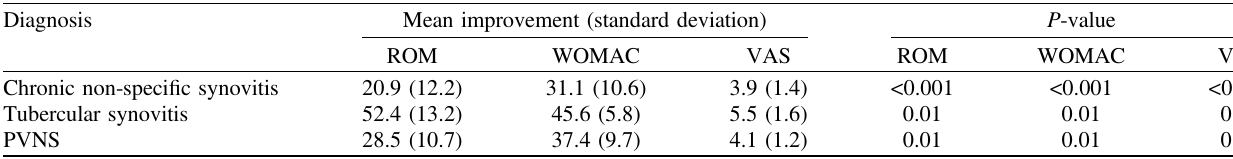
Table 6. Comparison of outcome parameters of different diseases.